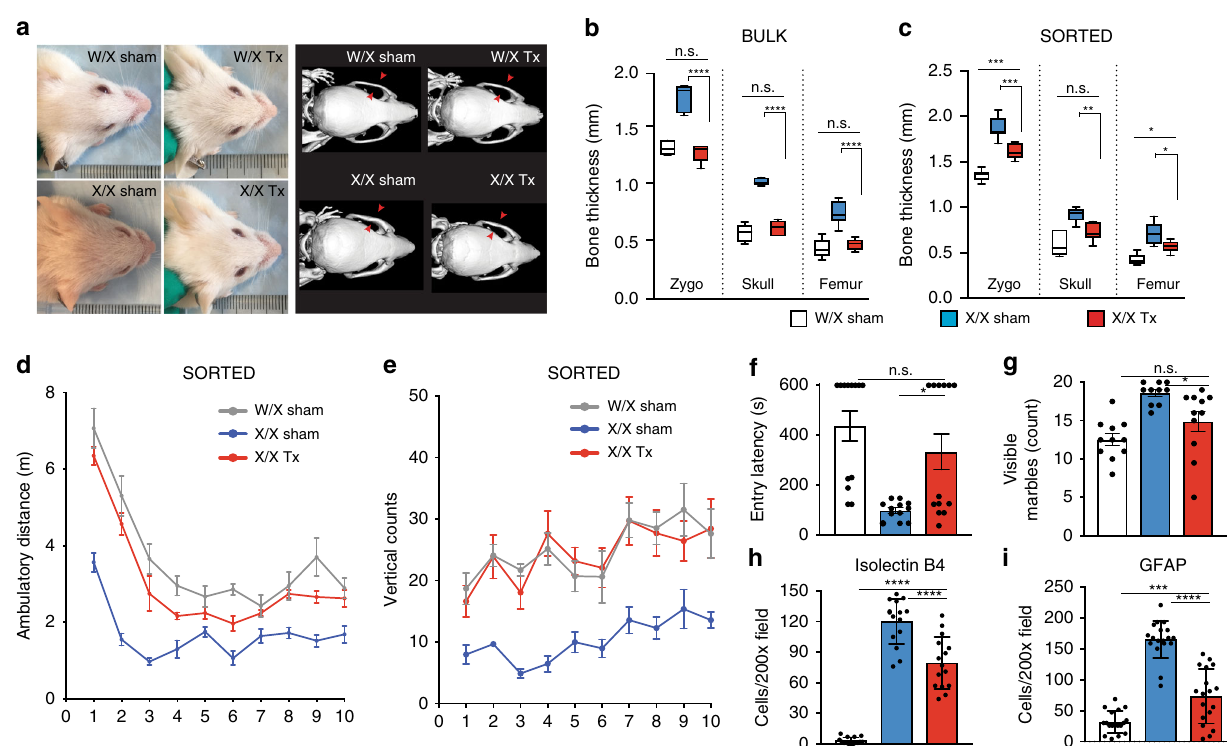
Fig. 5 Phenotypic reconstitution in NSG-IDUA X/X mice by human IDUA-HSPCs. a Representative photos showing facial features in mice transplanted with bulk cells. b Bony features in mice transplanted with bulk cells (W/X sham (clear), X/X sham (blue), and X/X Tx (red), n = 5 mice per cohort. Box plots with whiskers show median, min and max. c Bony features in mice transplanted with sorted cells (W/X sham (clear or gray, n = 11), X/X sham (blue, n = 10), and X/X Tx (red, n = 11). d Ambulatory distance in mice transplanted with sorted cells. W/X sham vs. X/X sham: **; W/X sham vs. X/X Tx: n.s.; X/X sham vs. X/X Tx: *. e Vertical rearing in mice transplanted with sorted cells. W/X sham vs. X/X sham: *; W/X sham vs. X/X Tx: n.s.; X/X sham vs. X/X Tx: *. f Memory retention in mice transplanted with sorted cells. g Quanti fi cation of digging behavior in mice transplanted with sorted cells. h – i . Measurement of neuroin fl ammation in the cerebral cortex, n = 3 mice in fi ve sections. h Microglia (Isolectin B4, n = 15 brain sections from three independent mice, and i astrocytes (GFAP, n = 15 brain sections from 3 independent mice. For d – g , data shown as mean ± SEM. For h – i , data shown as mean ± SD. All comparisons between groups were performed using one-way ANOVA test and post hoc comparisons were made with the Tukey ’ s multiple comparisons test. * p < 0.05, ** p < 0.01, *** p < 0.001, and **** p < 0.0001. Open fi eld testing and vertical rearings were analyzed using within-subject modeling by calculating the area under the curve for each mouse within the fi rst fi ve minutes and comparing between groups with one-way ANOVA. Source data are provided as a